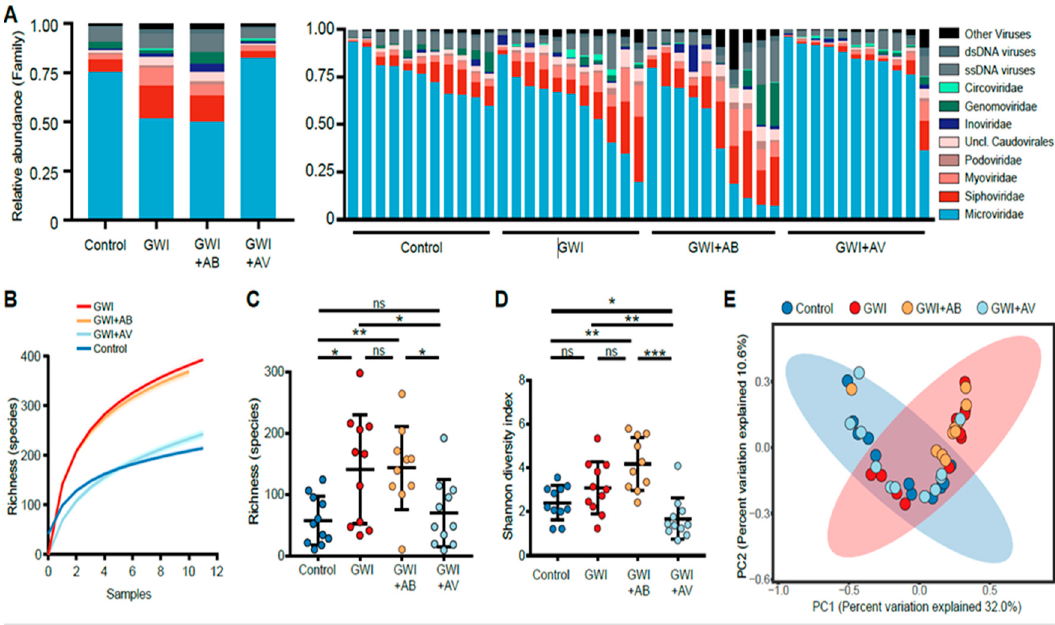
Figure 1. Virome alterations in a mouse model of Gulf War Illness. ( A ) The relative abundance of DNA virome is shown of the treatment group average (left) and by individual mice (right). ( B ) Rarefaction curves of virome richness are plotted with an increasing number of mice sub-samplings from each treatment group. Curves represent the average of 500 iterations at each sub-sampling depth. ( C ) Viral species richness of each group and ( D ) Shannon diversity index of virus species is shown. Statistical significance was assessed by Mann–Whitney U test; * p < 0.05, ** p < 0.01, *** p < 0.001, ns not significant. ( E ) Principal coordinate analysis (PCoA) of binary Jaccard distance of virome species. Treatment groups are indicated respectively. The 95% confidence intervals of the control group (blue) and GWI group (red) are shaded accordingly.